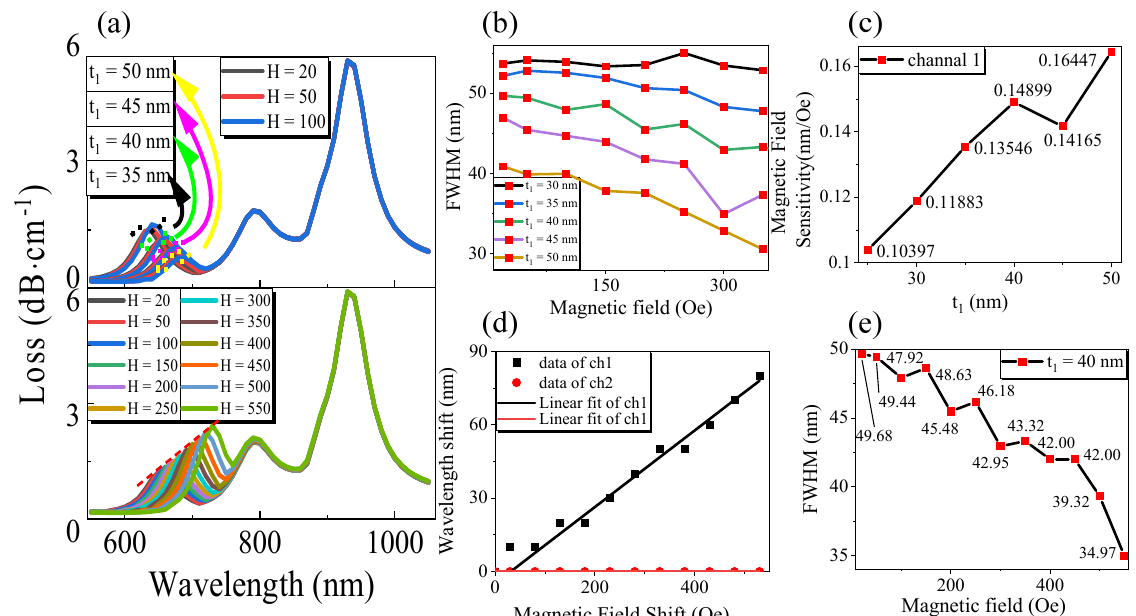
Figure 6. Optimization of metal film thickness t 1 structure of plasmonic optical fiber sensor under the same refractive index of T and liquid to be measured: ( a ) The variation of transmission loss with wavelength; ( b ) The FWHM of channel 1 varies with H under different thicknesses of t 1 ; ( c ) The variation of magnetic field intensity sensitivity with t 1 ; ( d ) The variation of resonant wavelength shift of channel 1 and channel 2 with magnetic field intensity and its linear fitting results; ( e ) The FWHM of channel 1 varies with the intensity of the magnetic field for t 1 = 40